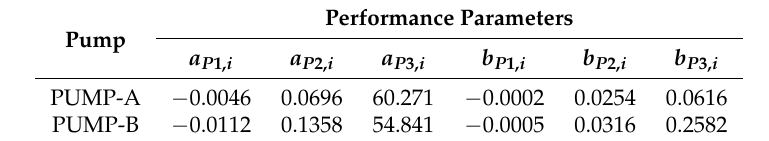
Table 2. Performance parameters of pumps.